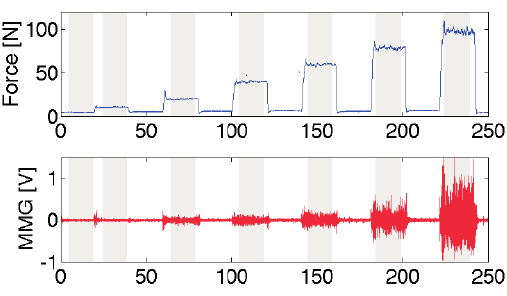
Figure 2. An example of an increase in the magnitude of MMG amplitude with increasing isometric force levels (5, 10, 20, 40, 60, 80, 100) N for 20 s contraction and 20 s resting between contractions